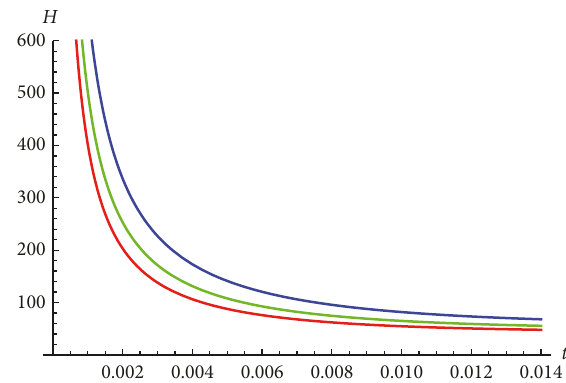
Figure 2: The diagram of the evolution of the Hubble function with respect to the cosmological time 𝑡 , which is described by (43) with 𝛼 21 ̸= 0 and 𝛼 2𝑛 = 0 for every 𝑛 > 1 . For illustration, two example values of the parameter 𝛼 21 = are chosen: −1 and −2 . The top blue curve describes the evolution of the Hubble function in the Λ CDM model. The middle curve describes one for 𝛼 bottom red curve describes one for 𝛼 21 = −2 . The Hubble function is expressed in km / s Mpc and the cosmological time 𝑡 is expressed in s Mpc / km.